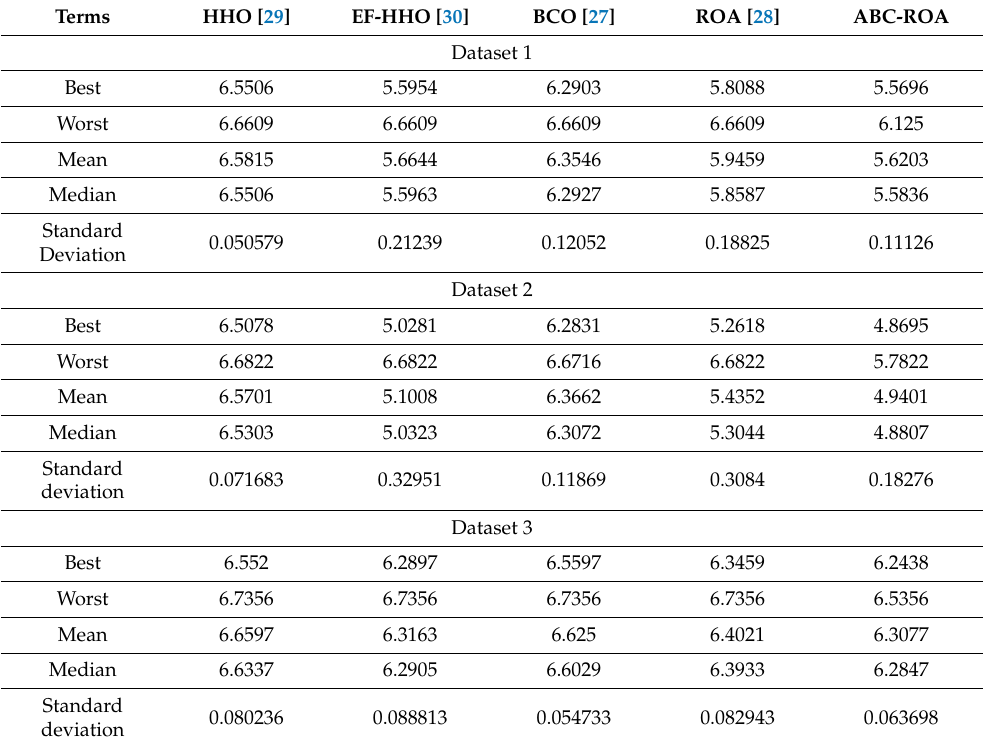
Table 4. Statistical analysis on developed data privacy preservation model over the Ethereum network.